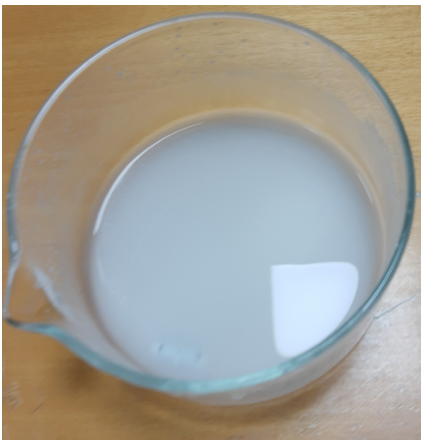
Figure 5. Mixture resulting from the solution of KI and starch in hot distilled water.